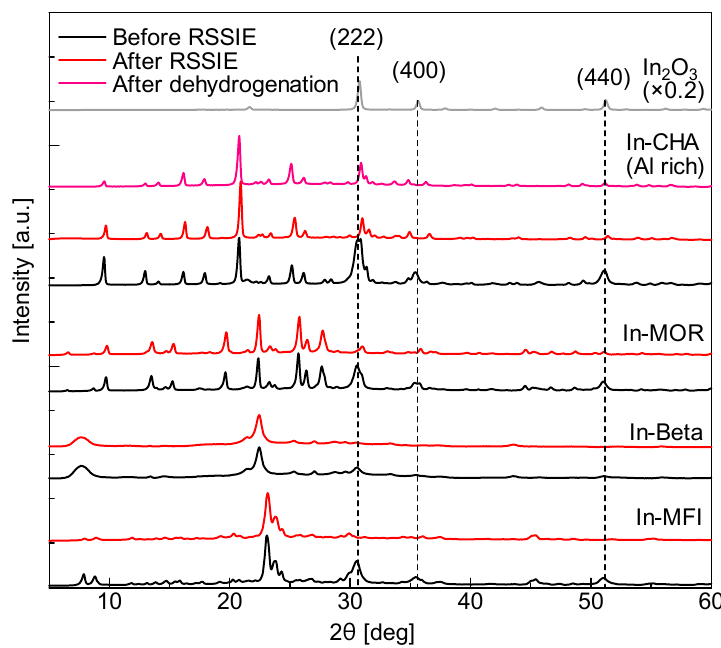
Figure 2. XRD patterns for In-MFI, In-BEA, In-MOR, and In-CHA(Al-rich) before (black) and after (red) RSSIE and for In-CHA(Al-rich) after the ethane dehydrogenation at 993 K (pink). The patterns were obtained at room temperature.